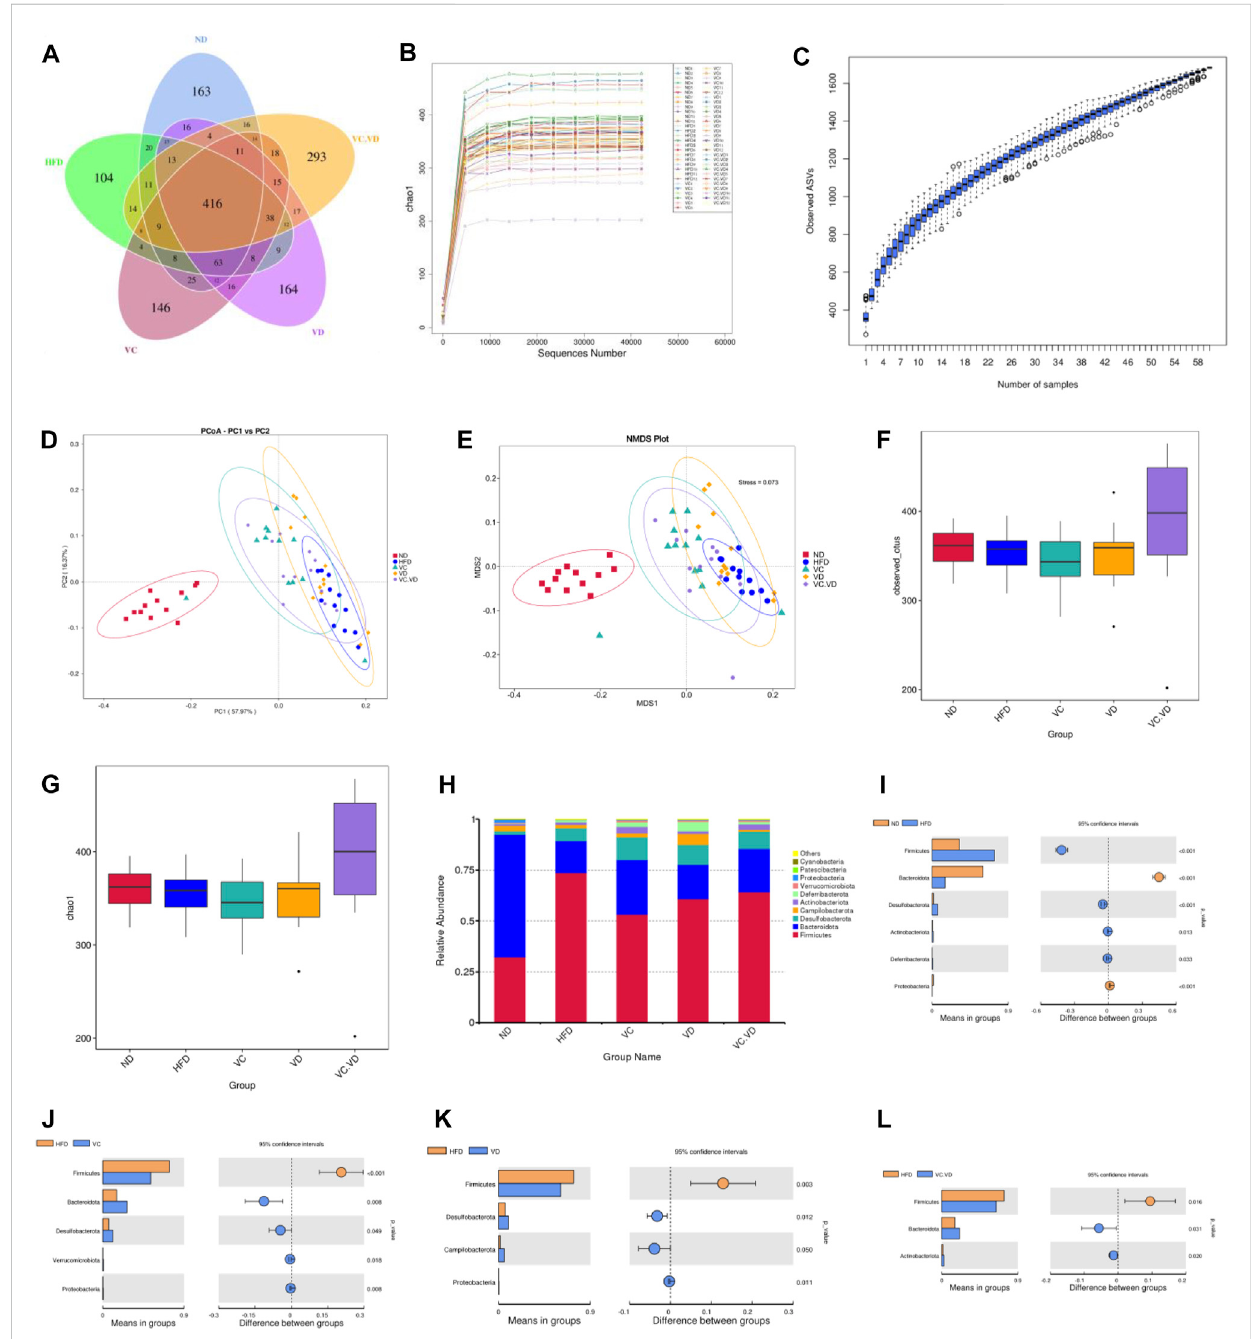
FIGURE 2 VC and VD 3 improved the gut microbiota in obese mice. (A) Venn diagram of the ASVs from the gut microbiota. (B) Rarefaction curve of chao1. (C) Species accumulation boxplot. (D – E) Weighted UniFrac PCoA and NMDS analysis of the gut microbiota based on the ASV data. (F – G) Alpha diversity analyzed by the observed_otus and chao1 index. (H) Relative abundances at the phylum level. (I – L) Discrepancy in the gut microbiota composition between groups at the phylum level. Species with signi fi cant differences between the ND and HFD groups (I) , HFD and VC groups (J) , HFD and VD groups (K) ,andHFDandVC+VDgroups (L) wereanalyzed.Asigni fi cantdiscrepancywasde fi nedas p < 0.05accordingtothe t -test.( n =12